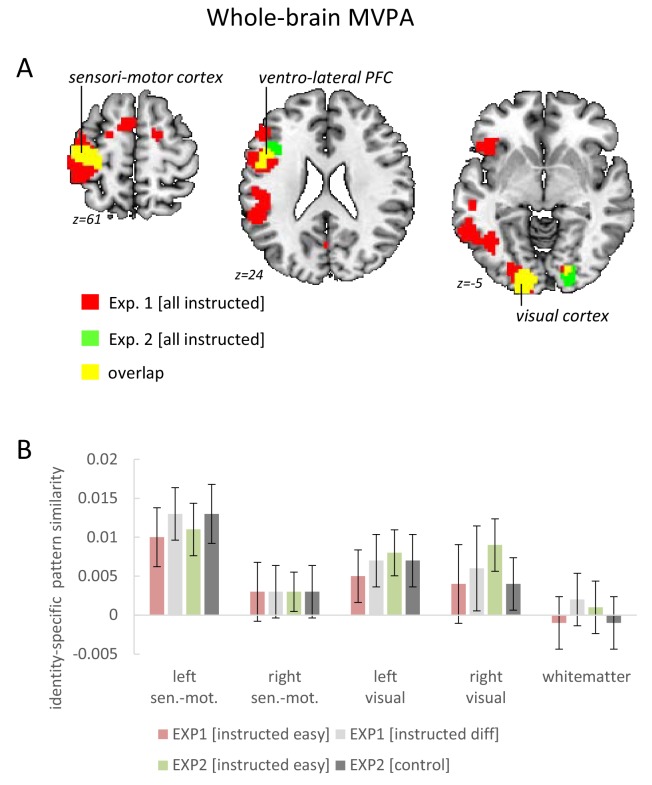
Results of the whole-brain searchlight MVPA testing for overall identity-specific pattern similarity effects.(A) Horizontal brain slices depicting the findings for the left sensorimotor cortex, the ventro-lateral PFC, and the visual cortex. For display purposes the map shows voxels with p<0.001 uncorrected. (B) Pattern-similarity effects broken by instruction difficulty (exp. 1) or instruction type (exp. 2). In addition to sensorimotor cortices and visual cortices, the white-matter volume is included as a control region to highlight the absence of analysis bias. For a comprehensive summary of ventro-lateral PFC results see Figure 5. Error bars represent 90% confidence intervals.